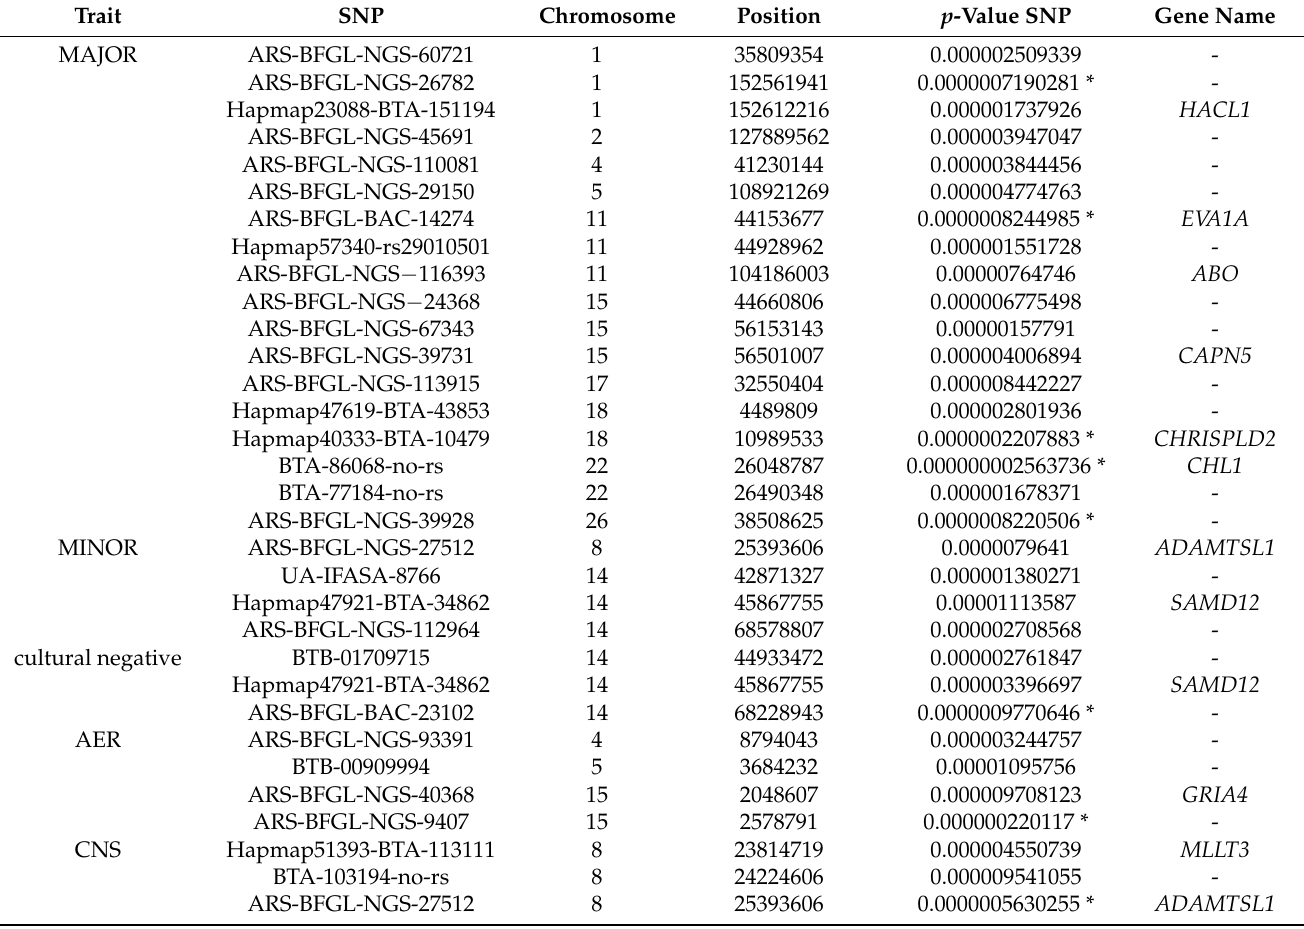
Table 2. Genome-wide significant SNPs for the main effect and potential candidate genes associated with the specific mastitis